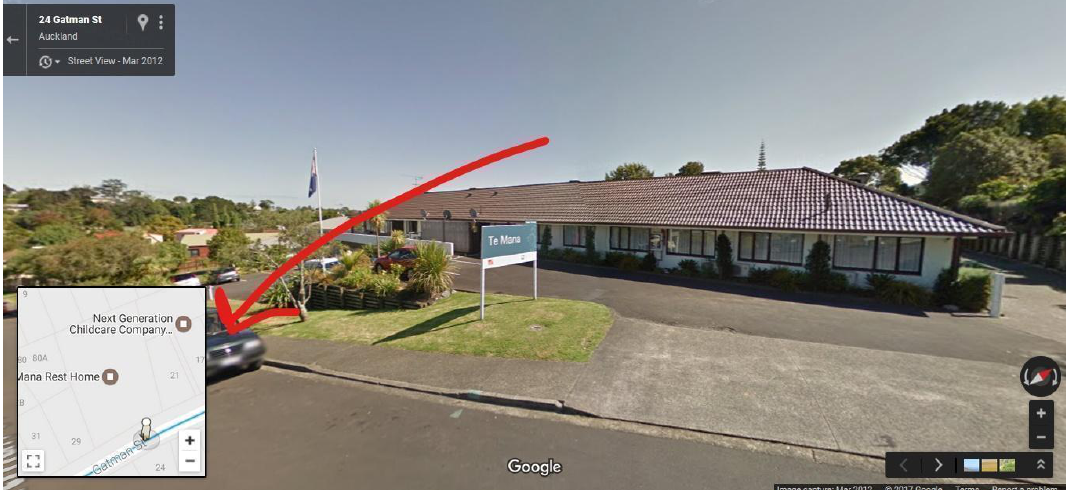
Figure A2. Map Tool Example.